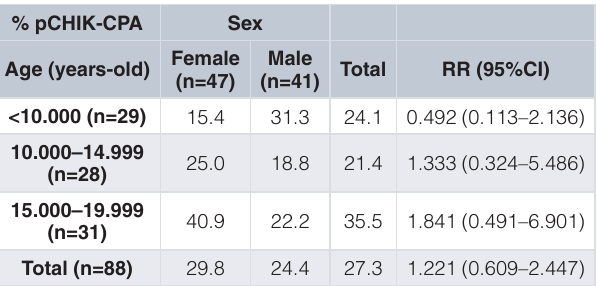
Table 3. Prevalence of pCHIK-CPA in those <20 years